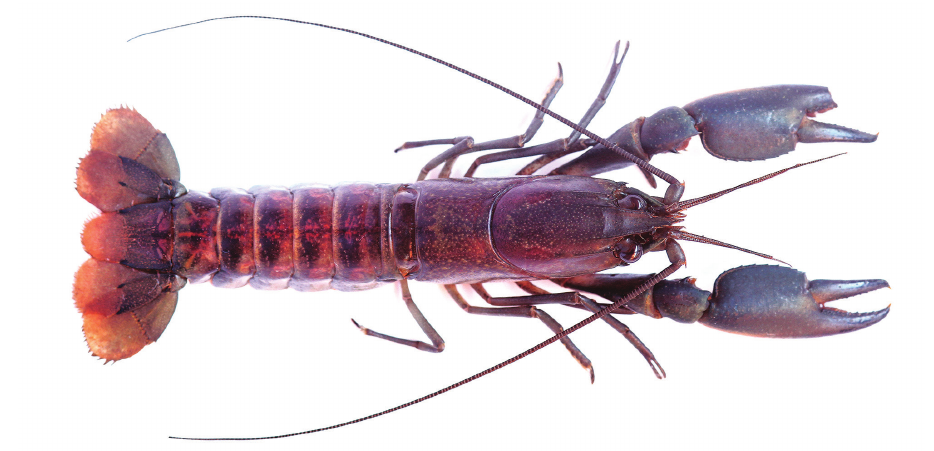
Figure 6. Cherax warsamsonicus sp. n., allotype female (MZB Cru